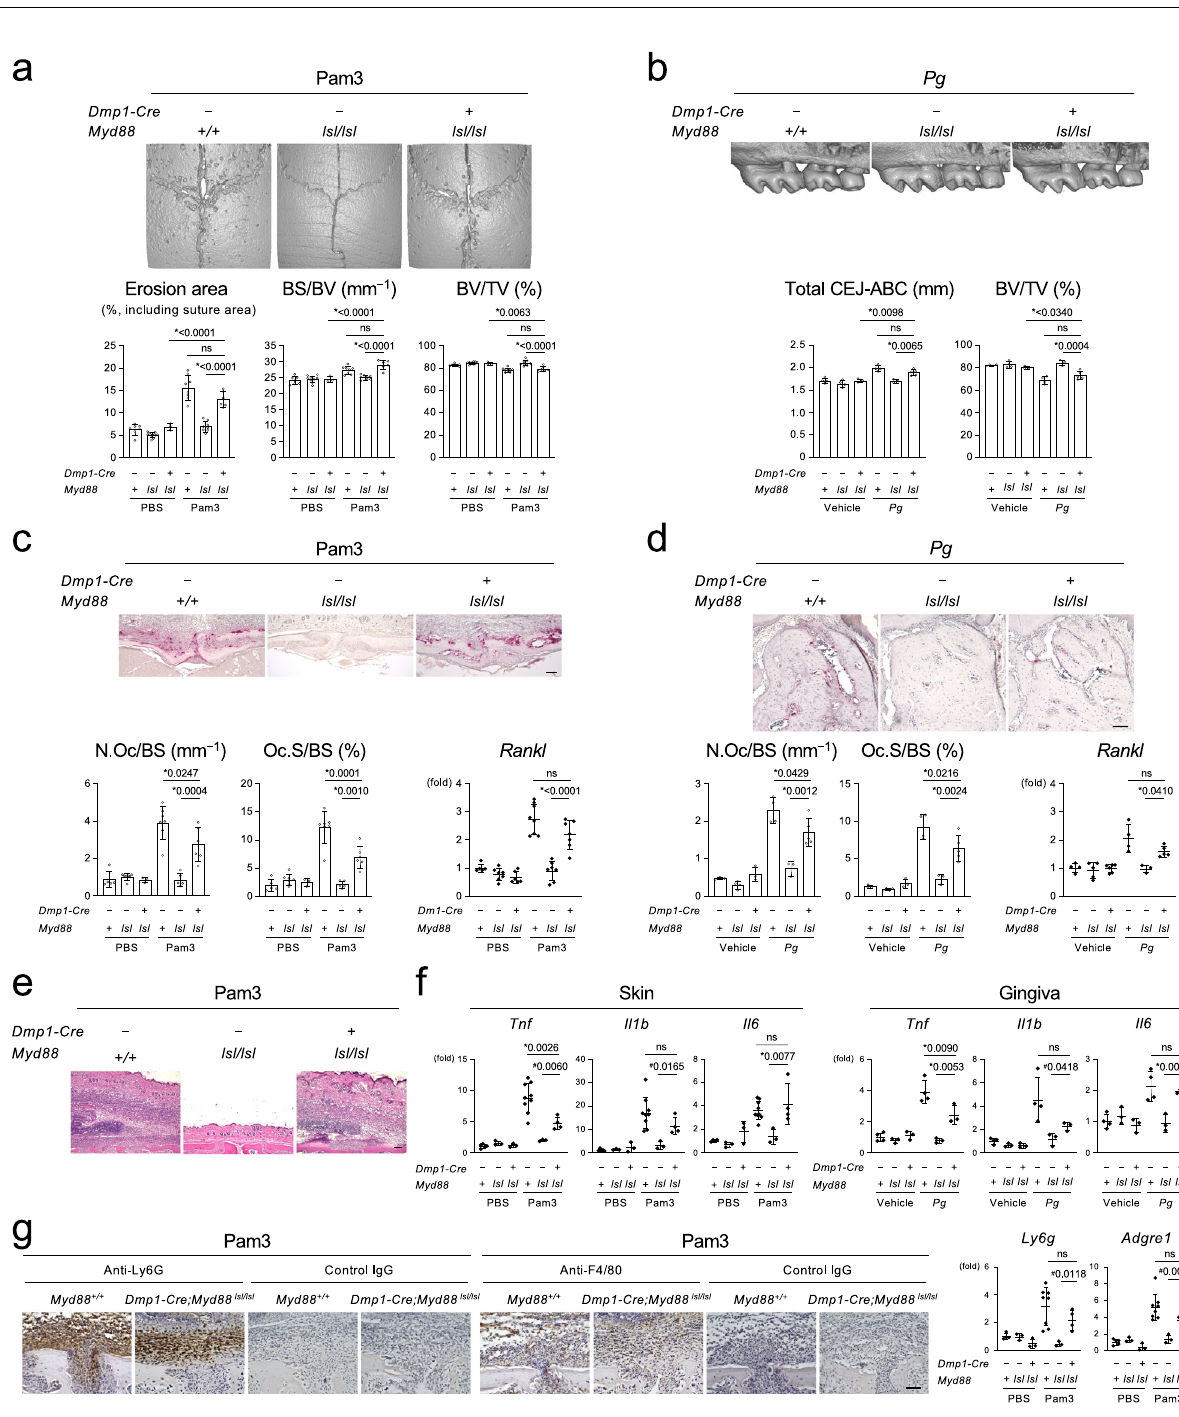
Fig. 2 | The TLR2-MYD88 axis in osteocytes and mature osteoblasts regulates osteolysis in periodontitis induced by Porphyromonas gingivalis infection. a – c , f Top: MicroCT images of the right maxilla. Representative images from each group of male mice ( n ≥ 5/group). Buccal side view. Bottom: The total CEJ-ABC distance of the right maxillary molars and alveolar BV/TV underneath the second molaroftherightmaxilla. a n =8,5,5,6inmale. n =5,5,8,6infemale. b n =5,5,7,6 in male. n =4, 6, 7, 7 in female. c CEJ-ABC: n =7, 9, 17, 13 in male. n =5, 8, 4, 11 in female. BV/TV: n =7, 8, 16, 10 in male. n =5, 8, 4,11 in female. f n =5, 5,5, 7 in male. n =3,6, 3,8infemale. d , e Top:TRAPstaining of the alveolarbone.Representative images from each group of male mice ( n ≥ 4/group). Scale bar=100 μ m. Bottom: